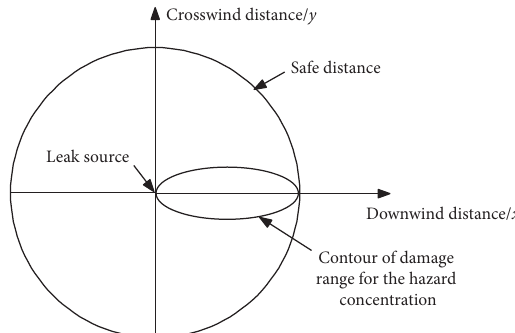
Figure 14: Schematic to determine the safety distance with the damage range of the hazard diffusion